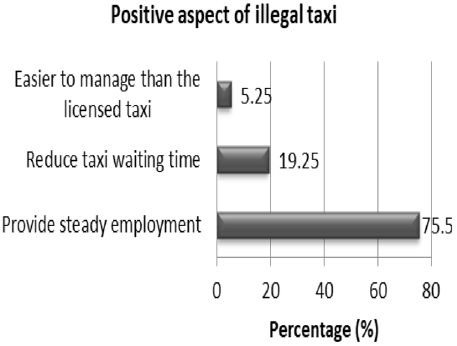
Figure 11. Positive